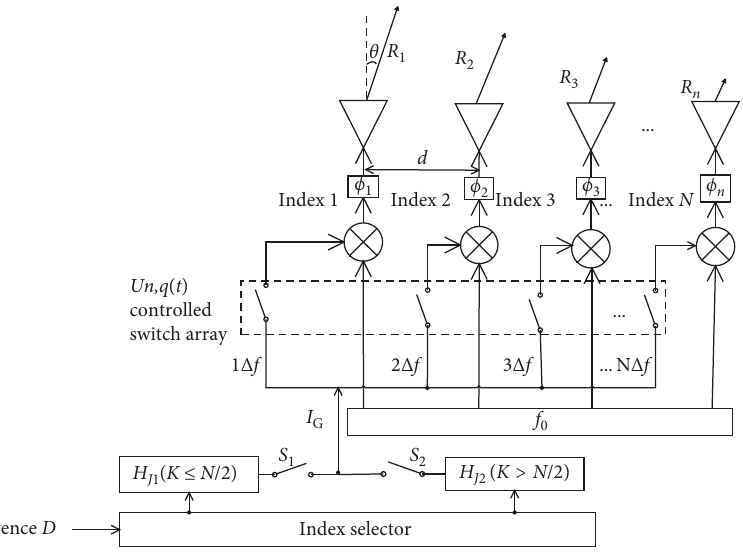
Figure 2: Architecture of proposed antenna element IM FDA